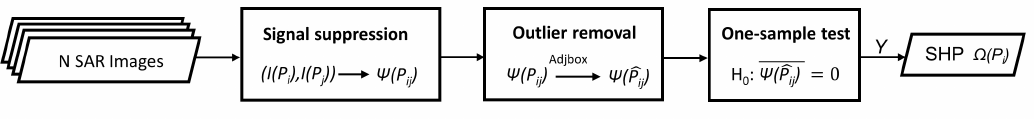
Figure 1. Research flowchart. The main procedures include three steps: (1) signal suppression; (2) outlier removal; and (3) one-sample